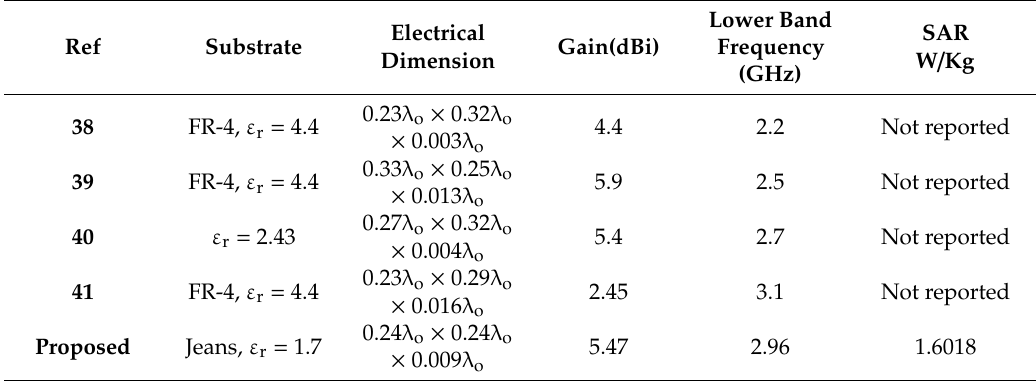
Table 4. Comparison of various UWB antennas.